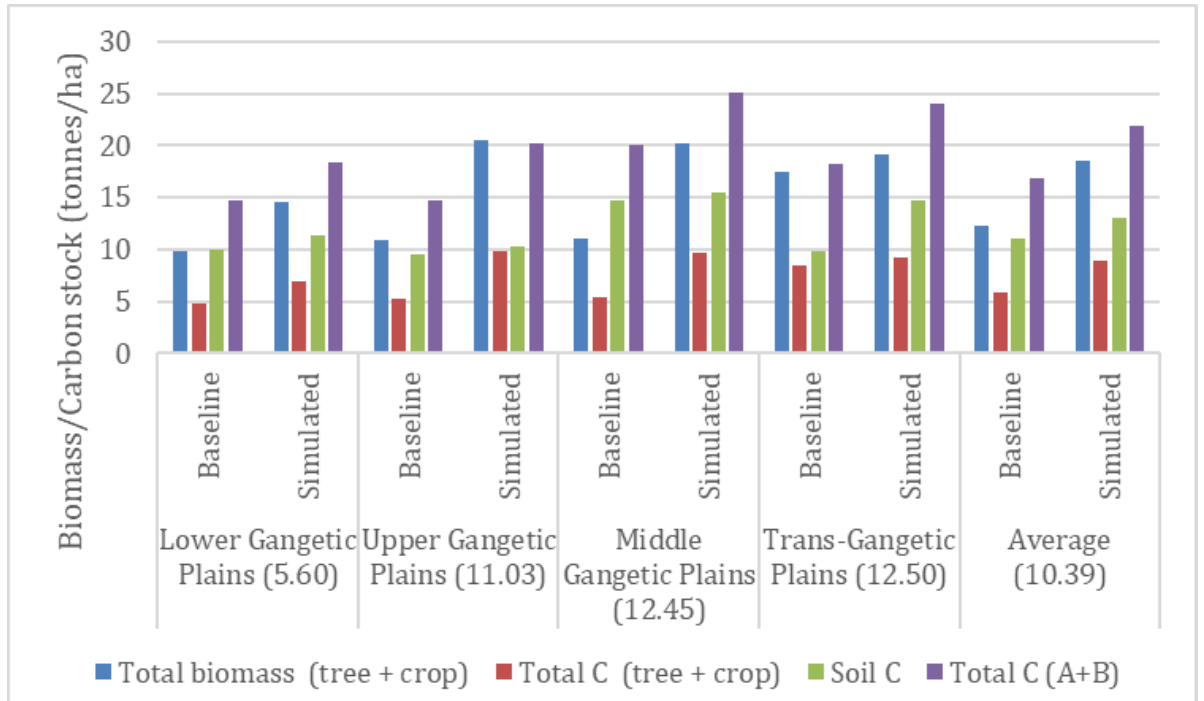
Figure 3. Biomass, soil carbon, and carbon stock available in agroforestry systems existing on farmer’s fields. Note: Baseline, 2013 and simulated for 30 years (2042). Parenthesis is tree density per hectare [70].